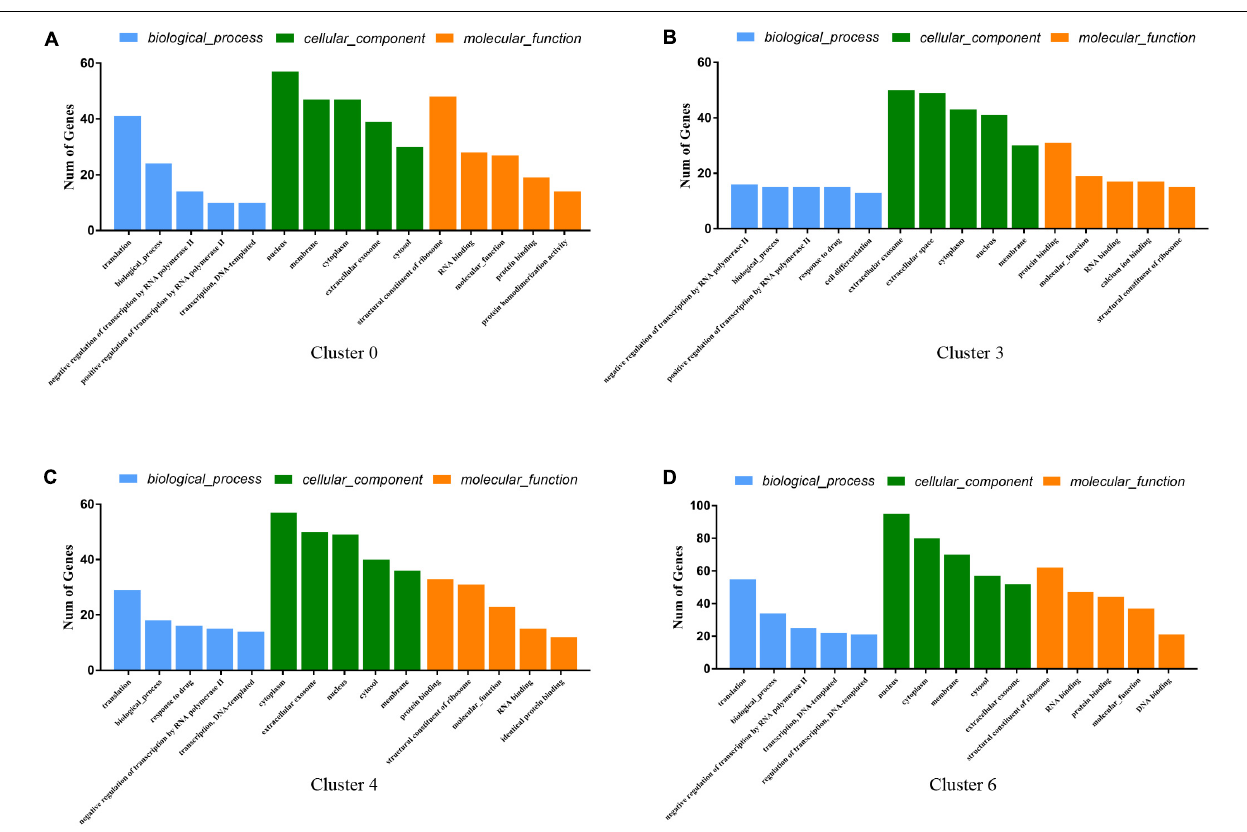
FIGURE 6 | GO enrichment analysis of genes for cluster 0 (A) , cluster 3 (B) , cluster 4 (C) , cluster 6 (D) . The Go functions include biological processes (BP, blue color), cellular components (CC, green color), and molecular functions (MF, yellow color). The horizontal coordinate-axis X is the item of go function, and the ordinate represents the genes enriched by different